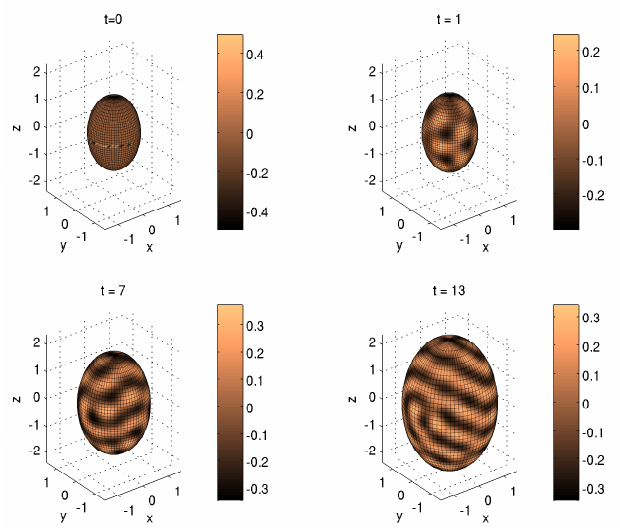
Fig. 3. Transient patterns generated by System (11) with R = 0 . 045 , ω = 60